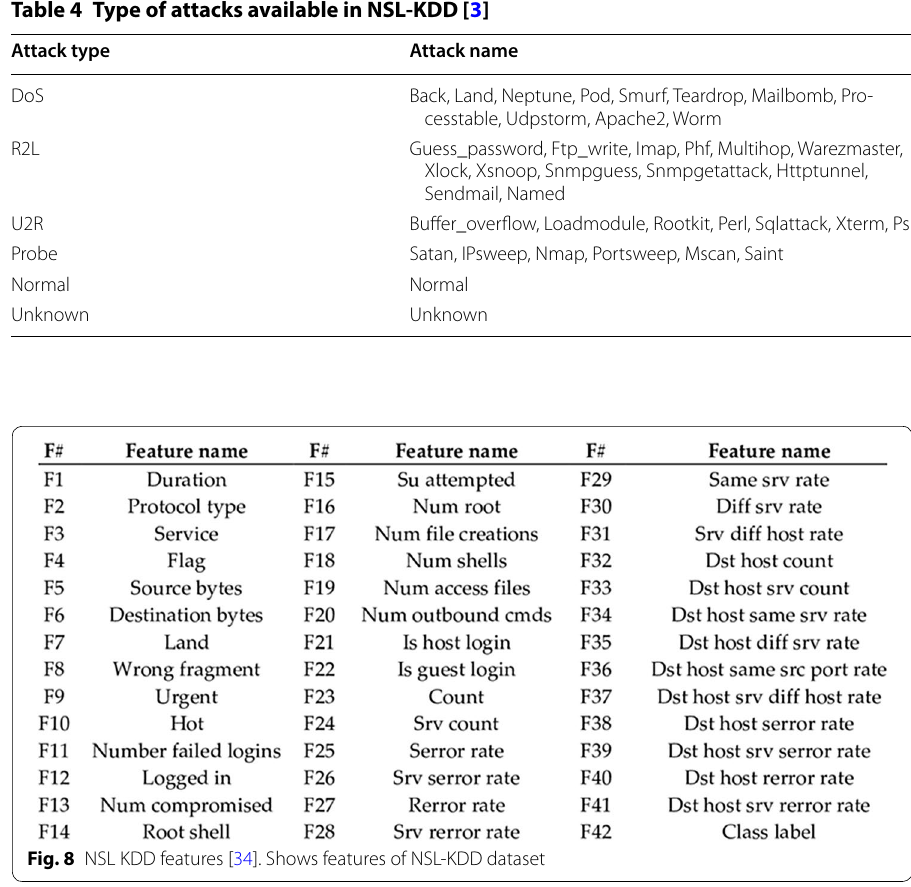
Type of attacks available in NSL‑KDD NSL-KDD contains 37 types of attacks that are categorized into 6 basic categories.